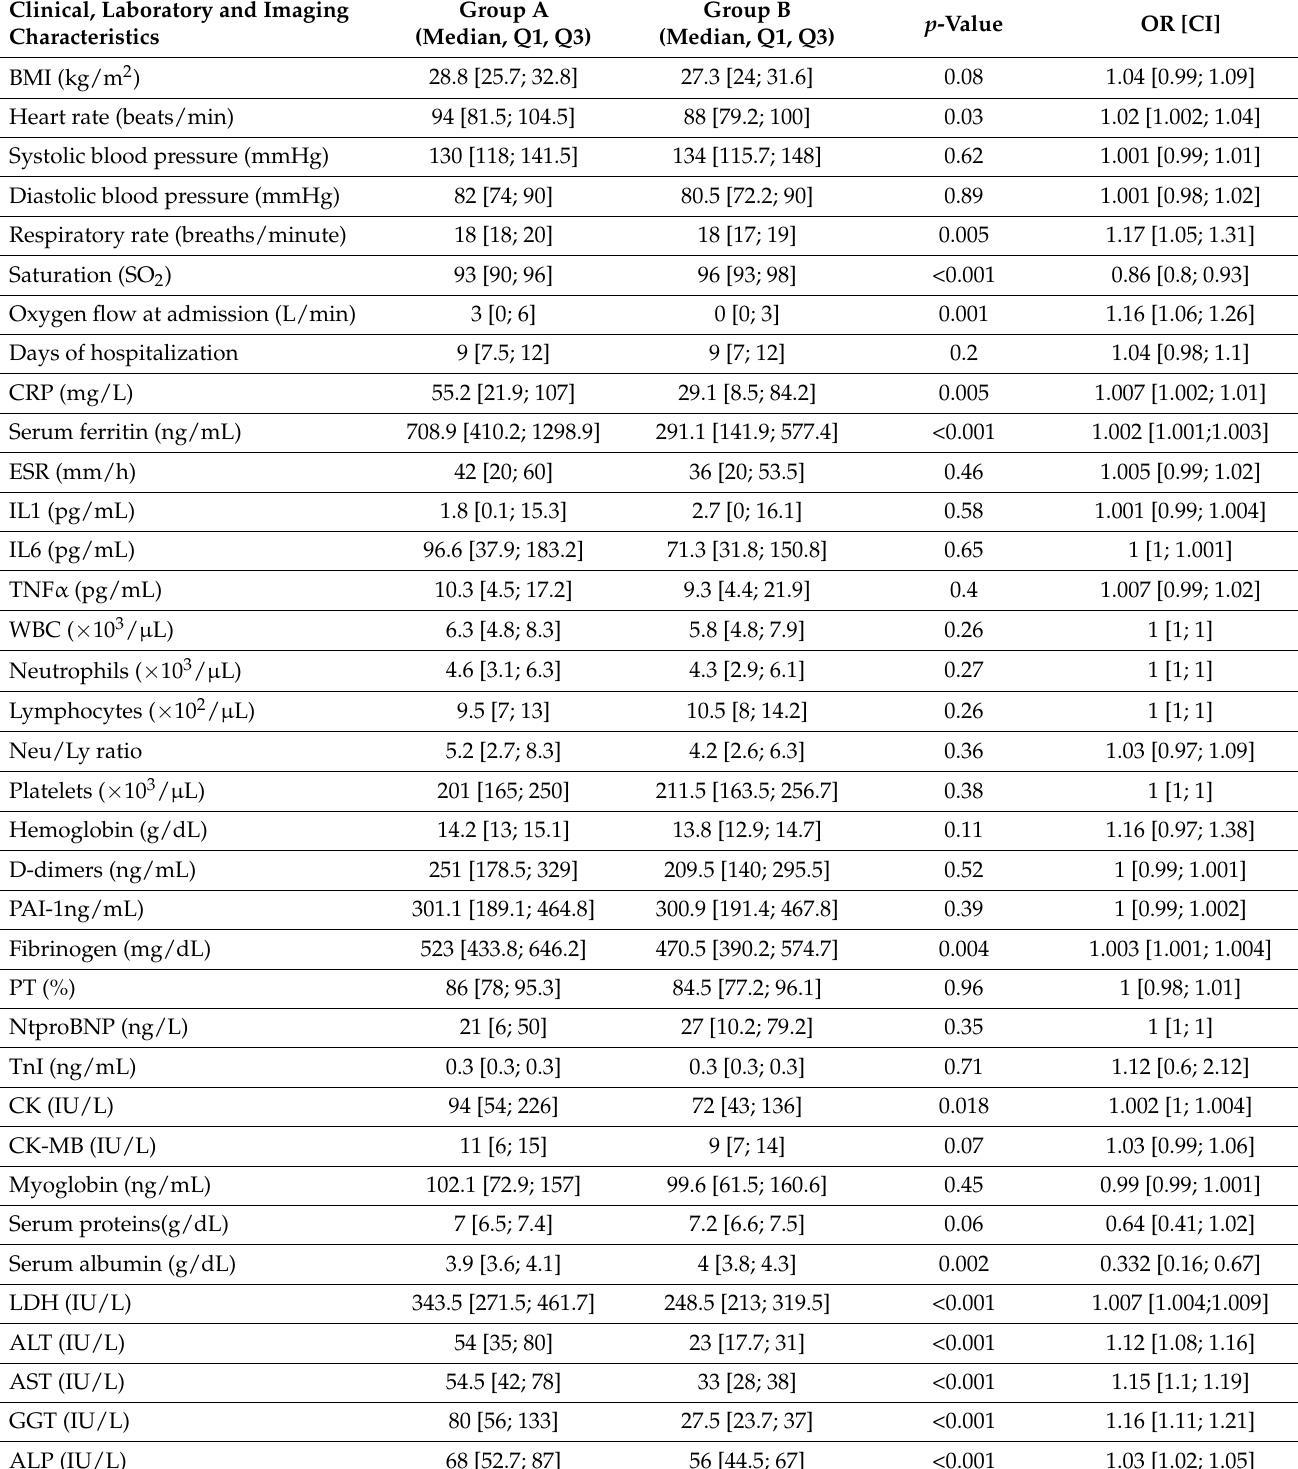
Table 2. Clinical, laboratory and imaging characteristics in COVID-19 patients with and without liver